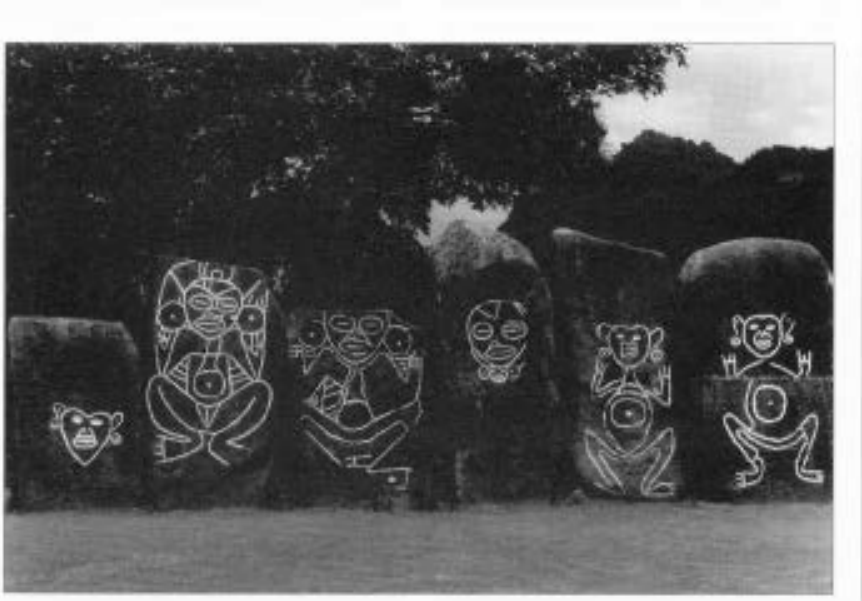
Figure 2 Iconography at the site U-10, Caguana ceremonial centre: the cacique or chief (head only) is flanked by pairs of high-ranking ancestors {left) and low-rankingfigures